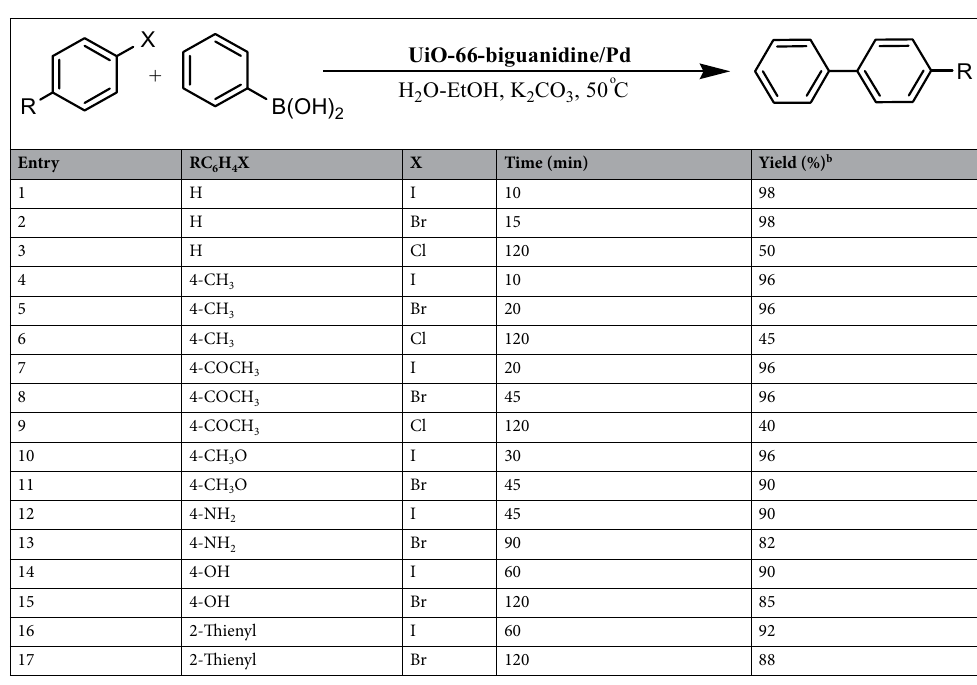
Table 7. Catalytic activity of UiO-66-biguanidine/Pd nanocomposite in Suzuki–Miyaura coupling reactions. a Reaction conditions: 1.0 mmol arylhalide,1.0 mmol phenylboronic acid, 2 mmol K